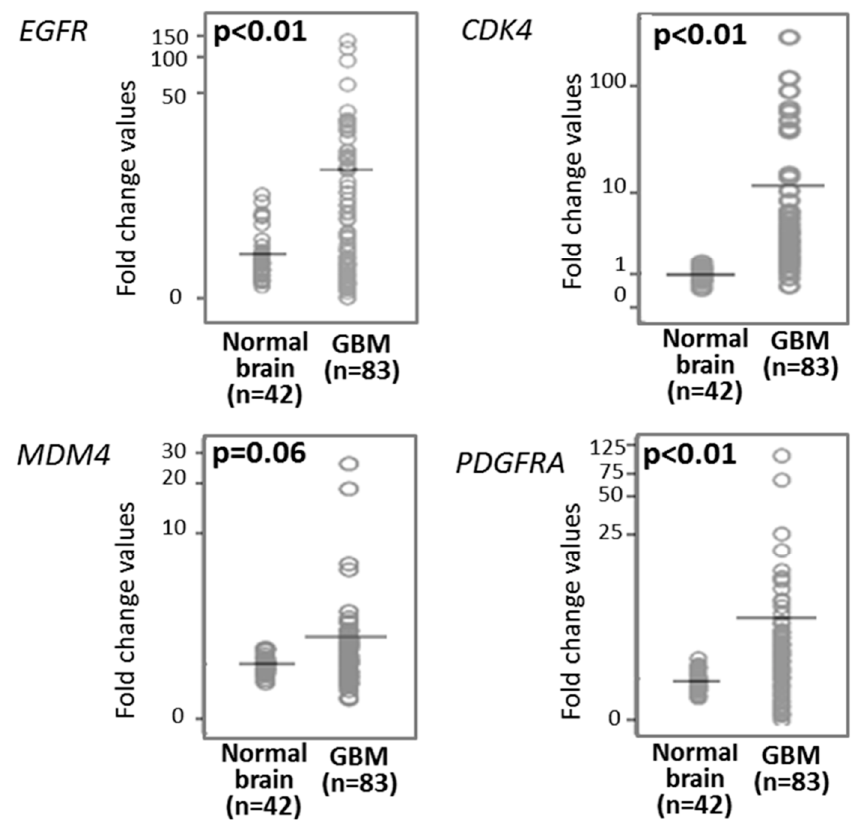
Figure 1. Epidermal growth factor receptor ( EGFR ), cyclin dependent kinase 4 ( CDK4 ), mouse double minute 4 ( MDM4 ), and platelet-derived growth factor receptor alpha ( PDGFRA ) gene expression levels in GBM ( n = 83) vs. normal brain tissues ( n = 42). (Non-parametric comparisons performed using the Mann–Whitney U test). (SPSS 25.0, IBM SPSS, Armonk, NY, USA). Table 2. Distribution of GBM according to the gene expression profiles (GEP) observed for the EGFR , CDK4 , MDM4 , and PDGFRA genes.